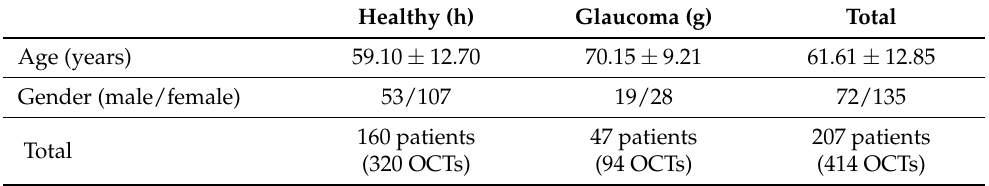
Table 2. Summary of the OCT dataset used to evaluate the asymmetry